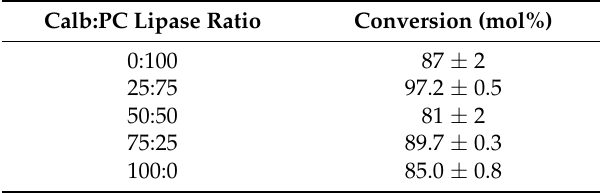
Table 5. Conversion to FAEEs using